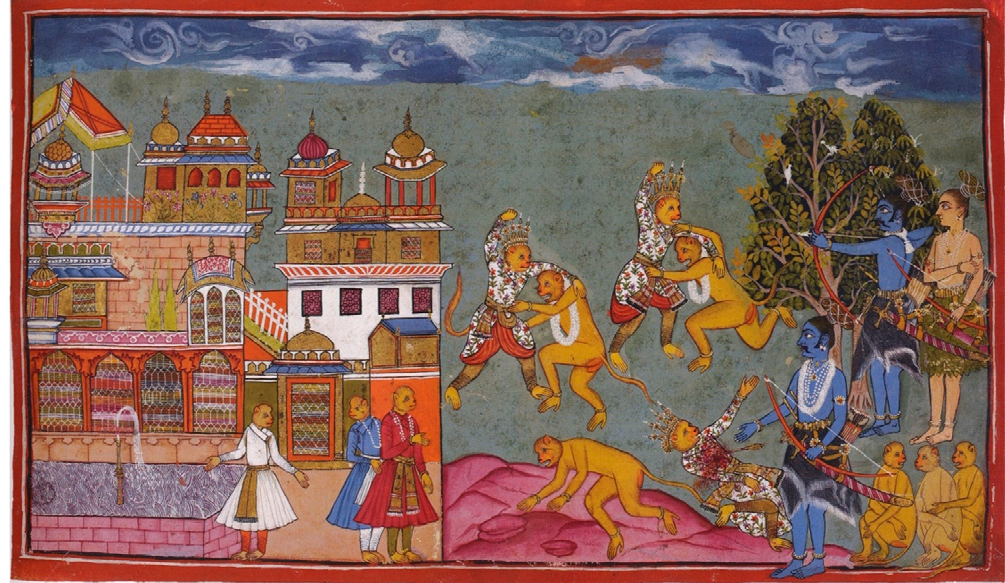
Figure 9. Rama Kills Valin, folio from Jagat Singh’s Ramayana manuscript, Mewar, ca. 1650-2, watercolor on paper. Courtesy: The British Library Add. MS 15296(2).